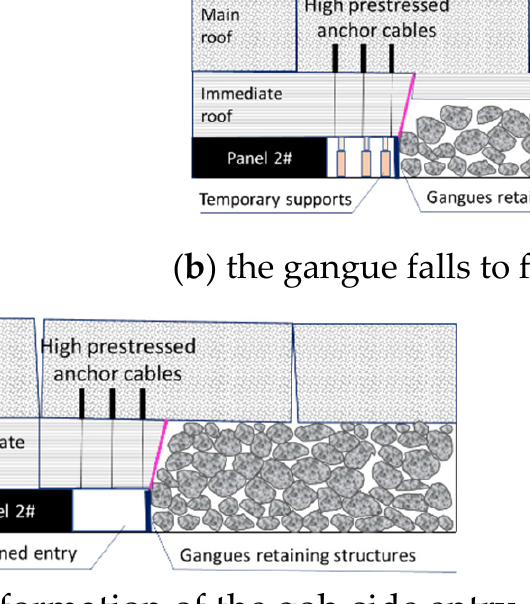
Figure 2. Evolution processes of surrounding rock structure.